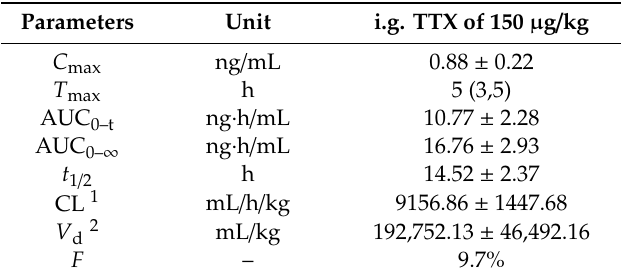
Table 5. Pharmacokinetic parameters of TTX in rats after i.g. sustained-release TTX